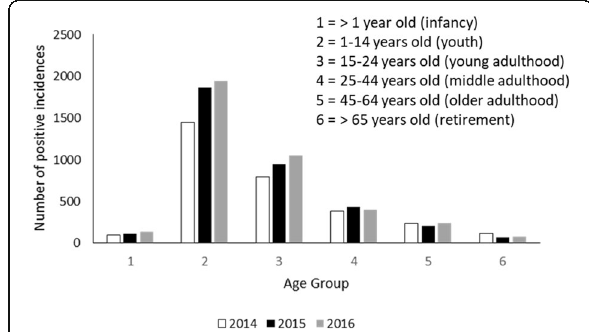
Fig. 5 Distribution of cases among age groups reported by Bandung hospitals 2014 – 2016